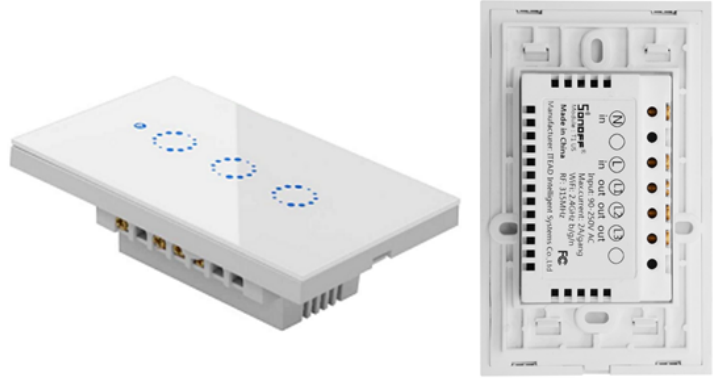
Figure 2. Sonoff T1